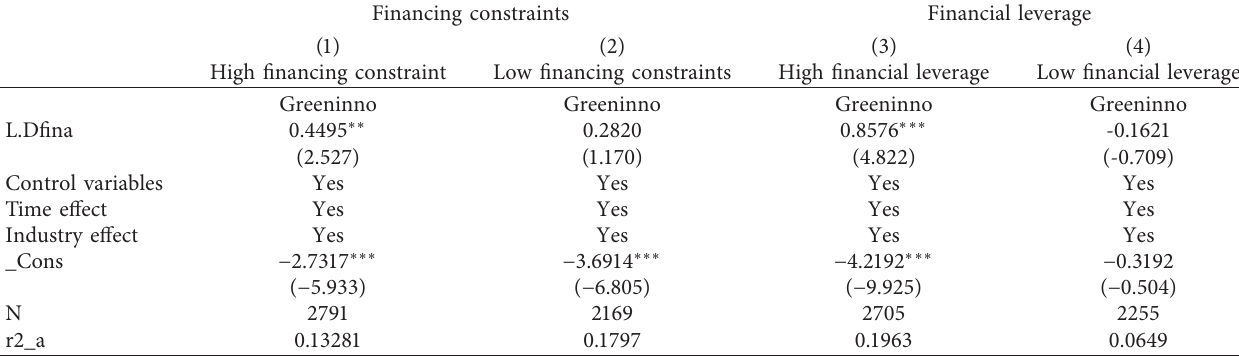
Table 3: Regression results of financing heterogeneity.